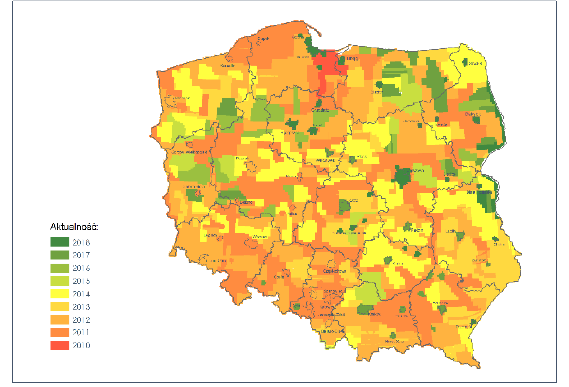
Figure 5 Actual state LIDAR data in national resource